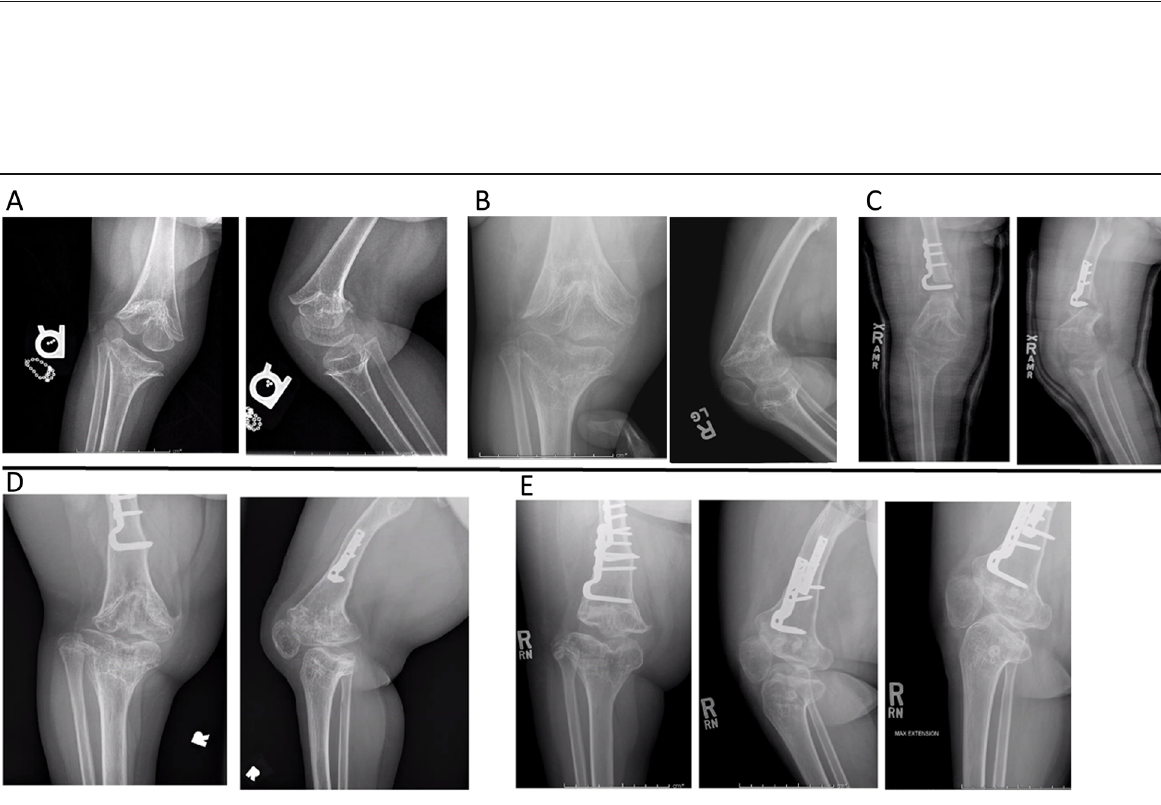
Fig. 2 a Right knee films, 2 years 9 months/ b: Right knee films, 5 years 7 months. c: Right knee films, 5 years 10 months. d: Right knee films, 10 years 11 months. e: Right knee films, 13 years 10